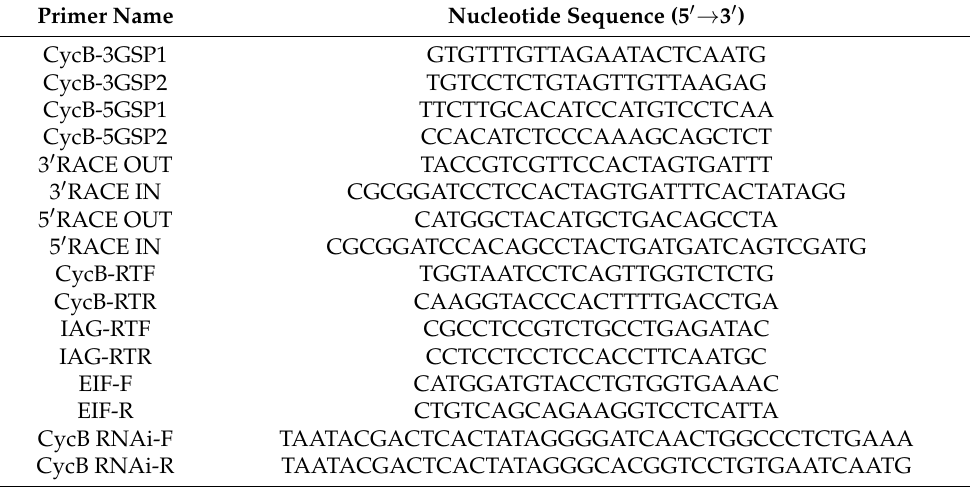
Table 1. Universal and specific primers used in this study.